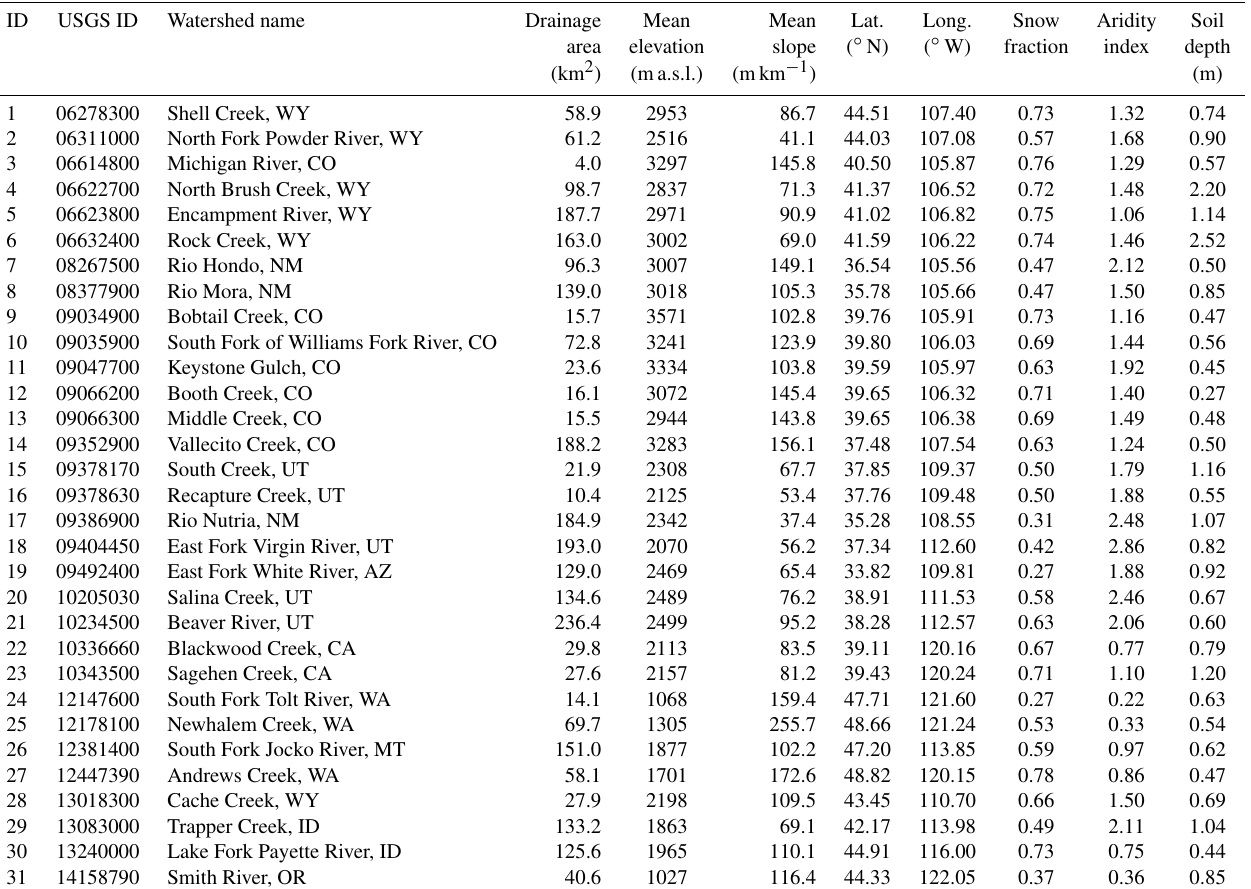
Table 2. List of the 31 watersheds from the CAMELS dataset included in this study. Data are from Addor et al. (2017). Note: USGS is the United States Geological